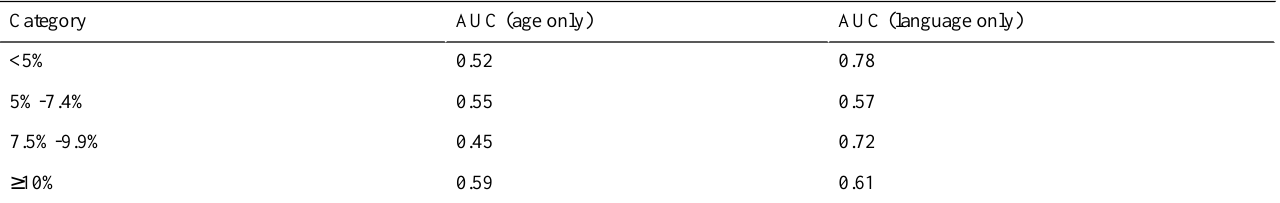
Table 2. Area under the curve (AUC) scores for each category of atherosclerotic cardiovascular disease risk scores from Model 1. AUC (language only)AUC (age only)Category 0.780.52<5% 0.570.555%-7.4% 0.720.457.5%-9.9% 0.610.59 ≥